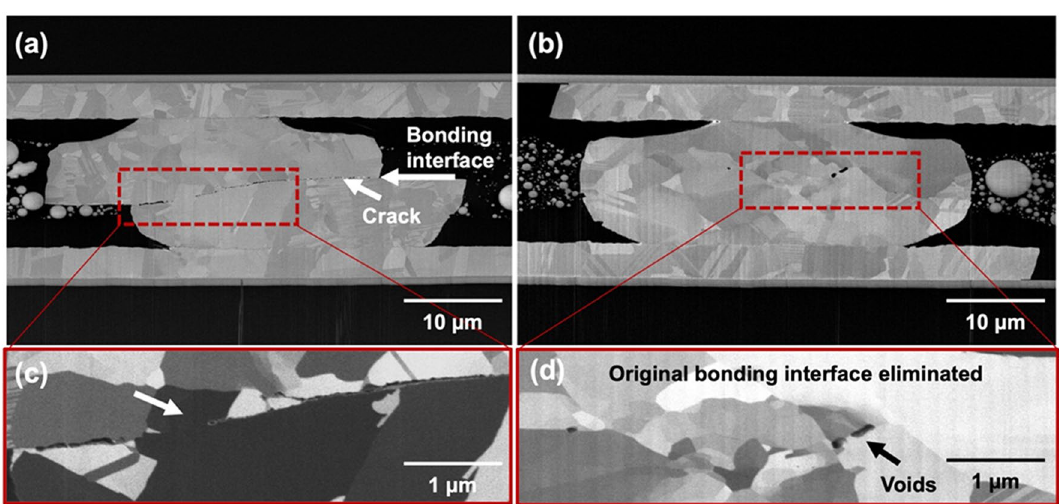
Figure 7. Cross-sectional FIB micrographs of the Cu joints bonded at 300 °C/47 MPa/10 s after 1000 thermal cycles: ( a , c ) the as-fabricated and ( b , d ) post-annealed samples. ( a , b ) The white arrows denote the original bonding interfaces. ( c ) The enlarged ion image of the ( a ) as-fabricated joints. Only one recrystallized grain grew across the interface. Cracks initiated and propagated along the bonding interface. ( d ) The enlarged ion image of the ( b ) post-annealed Cu joint. Only a few voids at the grain boundaries without cracks were observed in the post-annealed